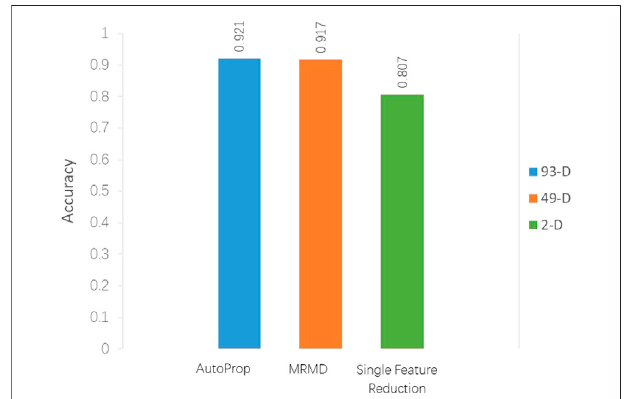
FIGURE 2 | Classi fi cation accuracy comparison between models with different feature selection